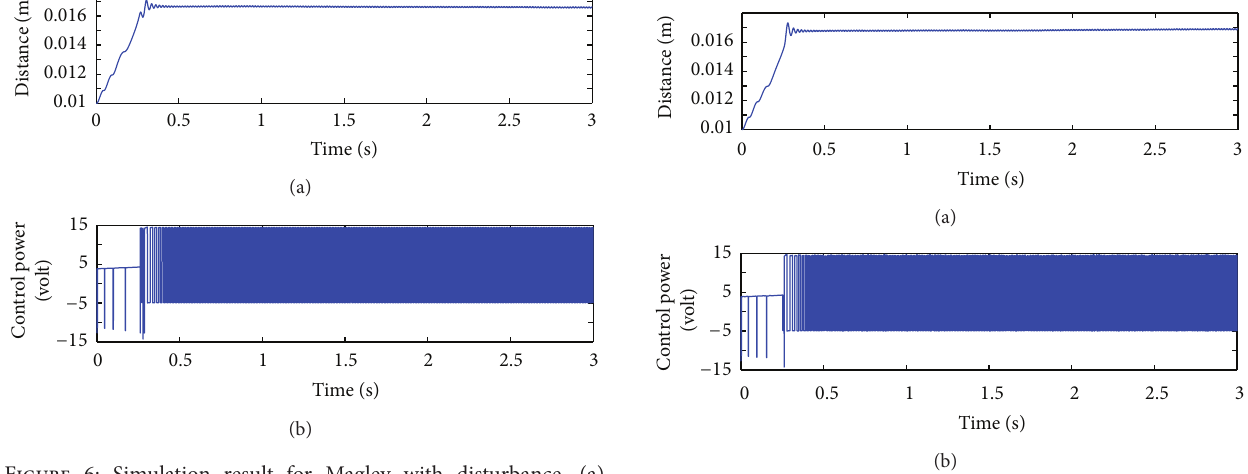
Figure 6: Simulation result for Maglev with disturbance. (a) Distance between train and rail, (b) control signal.